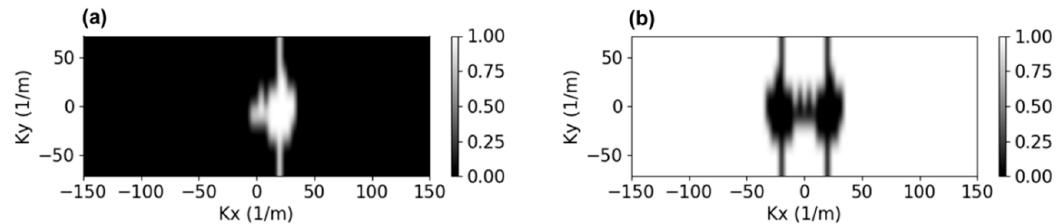
Figure 6. Filtering masks to extract ( a ) forward propagating surface waves ( M FP ) and ( b ) non- propagating oscillatory fields ( M NPO ). In the images, the white color represents complete pass and the black color complete reject of the masking function. Each mask is defined in f-k x -k y (3-D), but here is shown in k x -k y (2-D) at f = 43 kHz for visualization purposes.